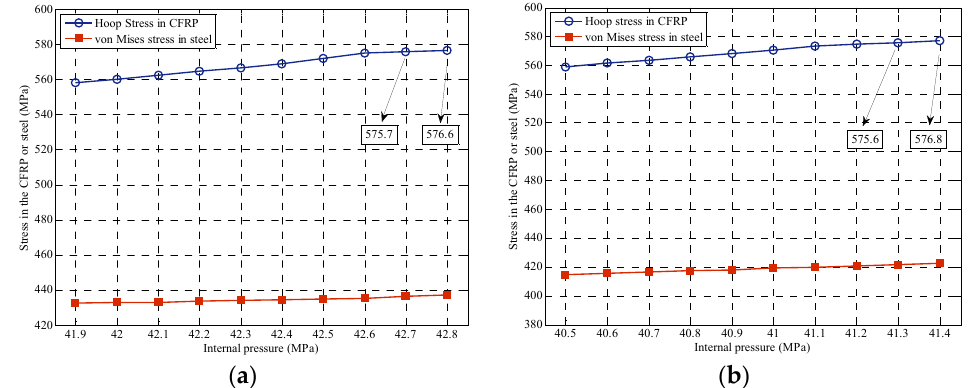
Figure 2. Maximum stress under different internal pressures for ( a ) 152.4 mm defect and ( b ) full- circle defect.